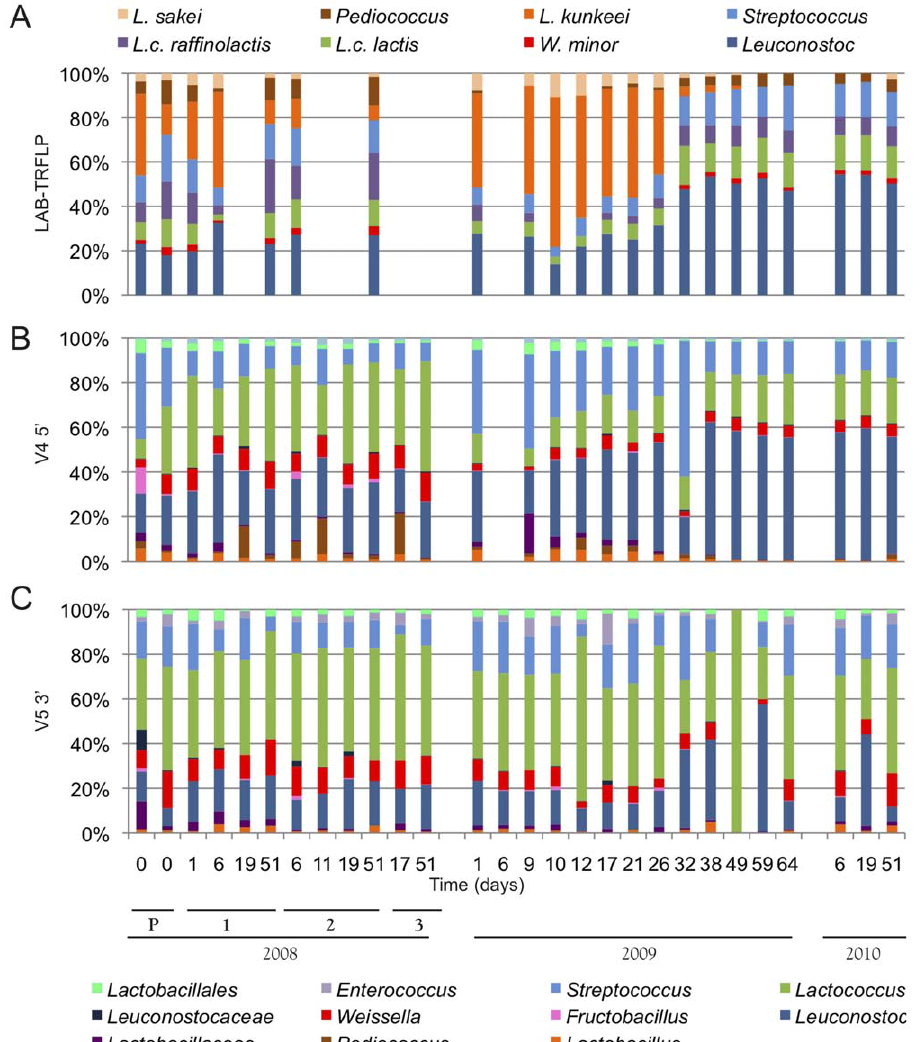
Figure 3. Lactobacillales community of Dolce fermentation revealed by LAB-TRFLP (Panel A), V4 5 9 read (Panel B) and V5 3 9 read (Panel C). Top, taxonomy key for LAB-TRFLP. Bottom, taxonomy key for V4 and V5 sequencing. Labeled bars indicate batch numbers (1–3) and vintage (2008 and 2009). y -axis represents relative OTU abundance. Missing samples were unable to amplify by LAB-TRFLP. P indicates 2008 press-pan samples.